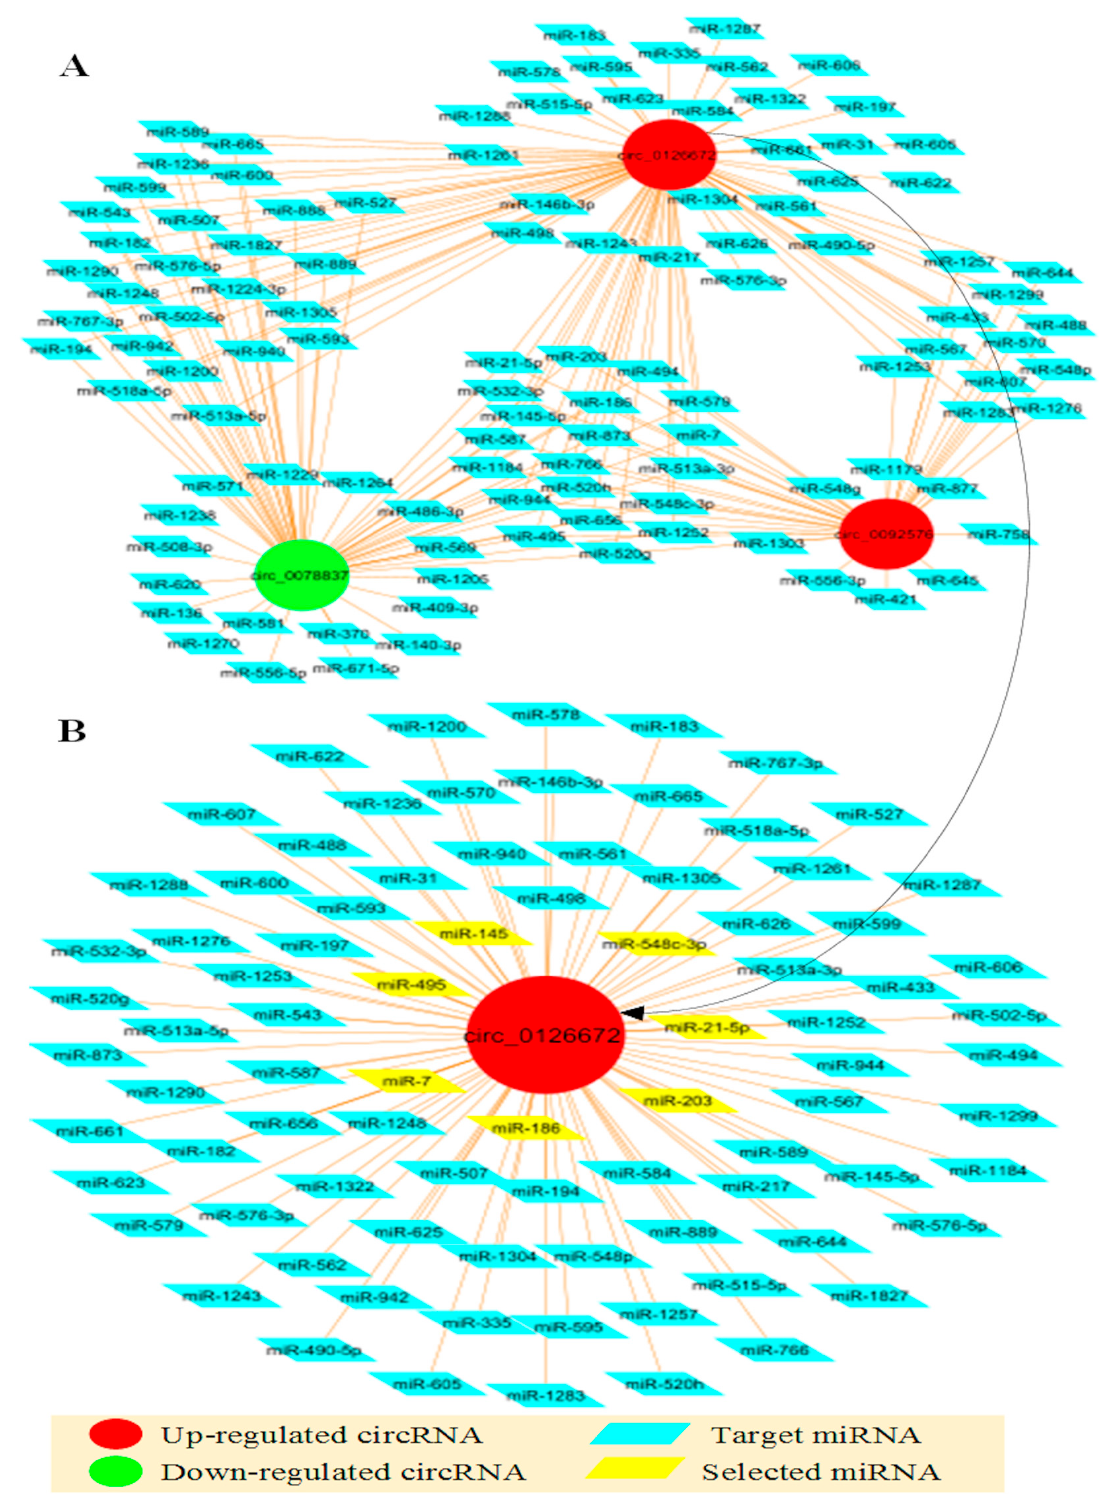
Figure 4. circRNA-miRNA networks. ( A ): Network of CHD dysregulated circRNAs and their target miRNAs. ( B ): Network of the CHD most relevant circRNA and its target miRNA